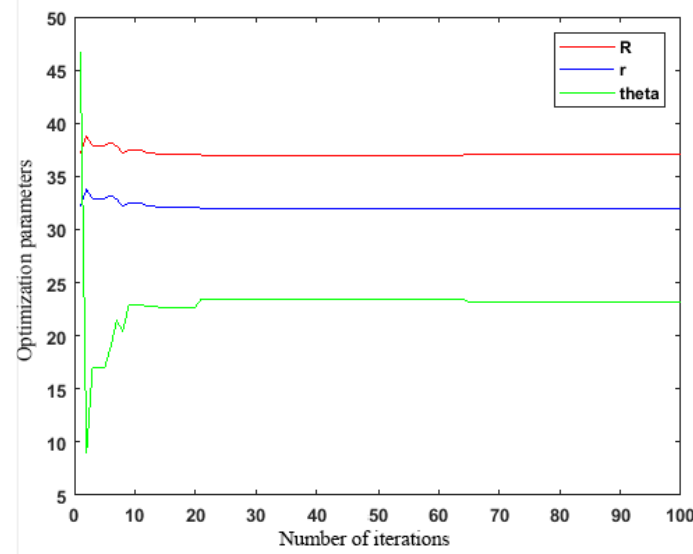
Figure 6. Optimized values of R , r and θ .